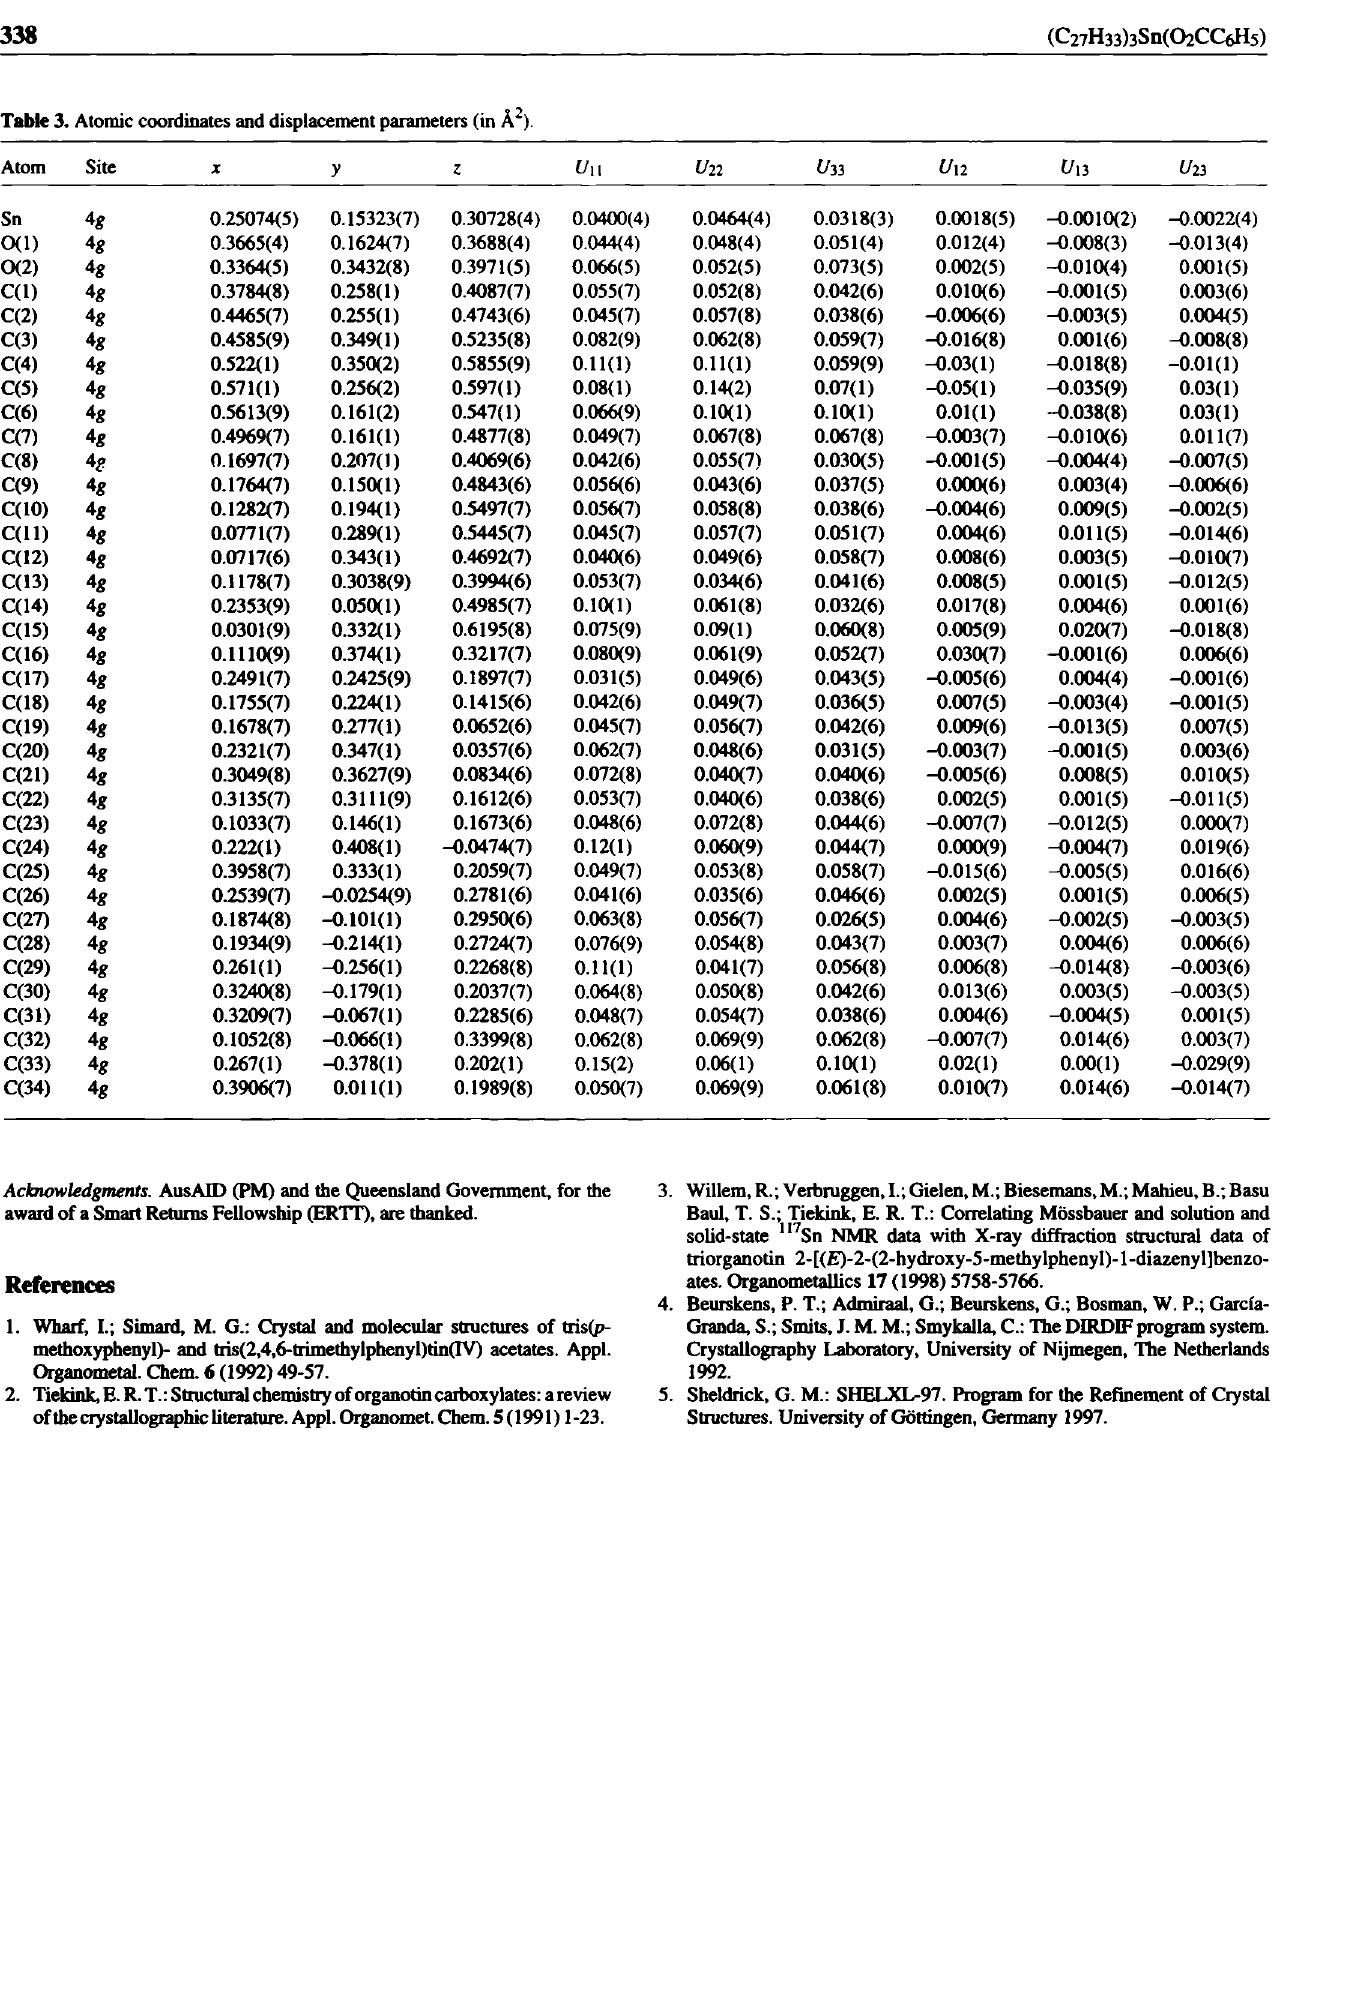
Table 3. Atomic coordinates and displacement parameters (in A 2